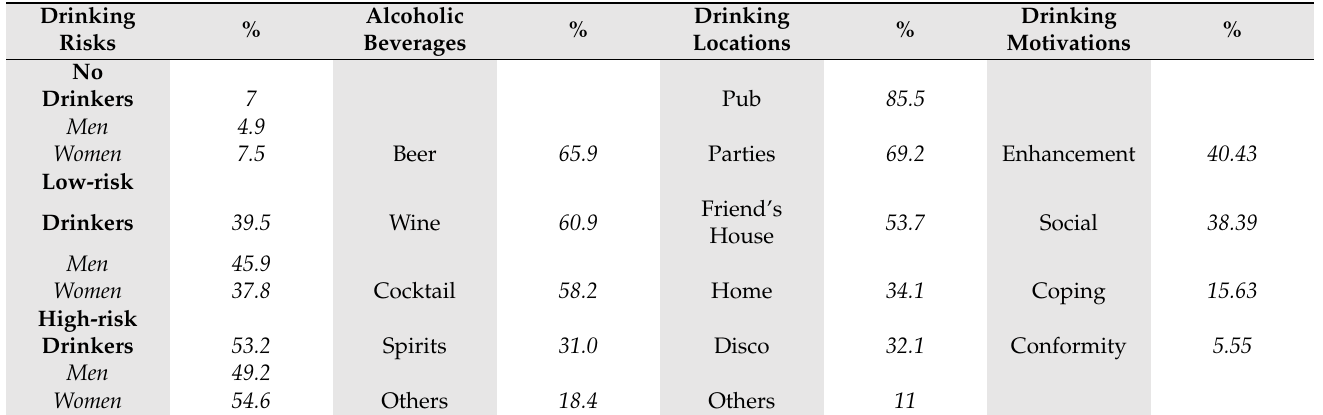
Table 4. Drinking Risks, Alcoholic Beverages, Drinking Locations and Drinking Motivations.